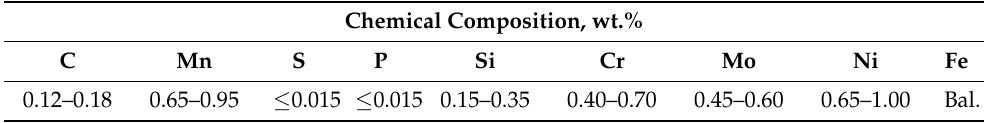
Table 5. Cladding parameters of the plasma transfer arc welding (PTAW) metal deposition of the surface layers on AISI 4715 steel. Process Parameters Value of Parameter Current, I (A) 80 Voltage, U (V) 25 Travel speed, S (mm/s) 2.7